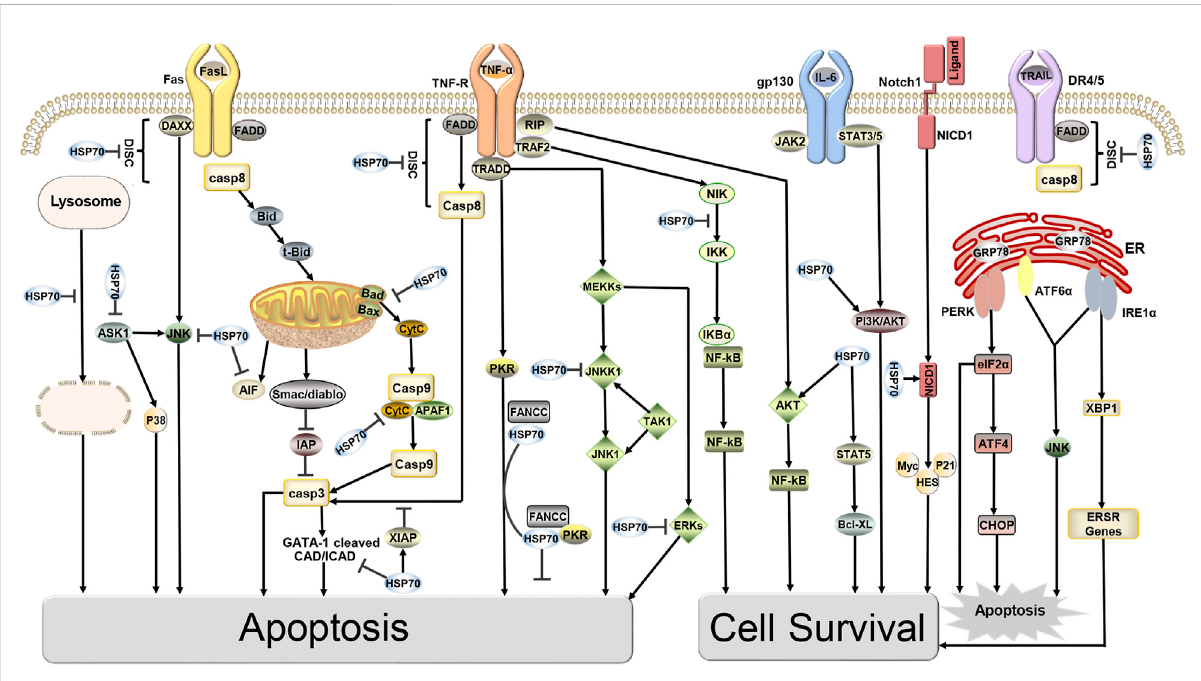
FIGURE 1 Targets of HSP70 in Apoptosis and Survival Pathways. HSP70 inhibits apoptosis, induces cell survival, and increases tumor resistance to radiotherapythroughvariouspathways,includingthemitochondrialpathway,deathreceptorpathway,DNAdegradationpathway,andendoplasmic reticulum stress